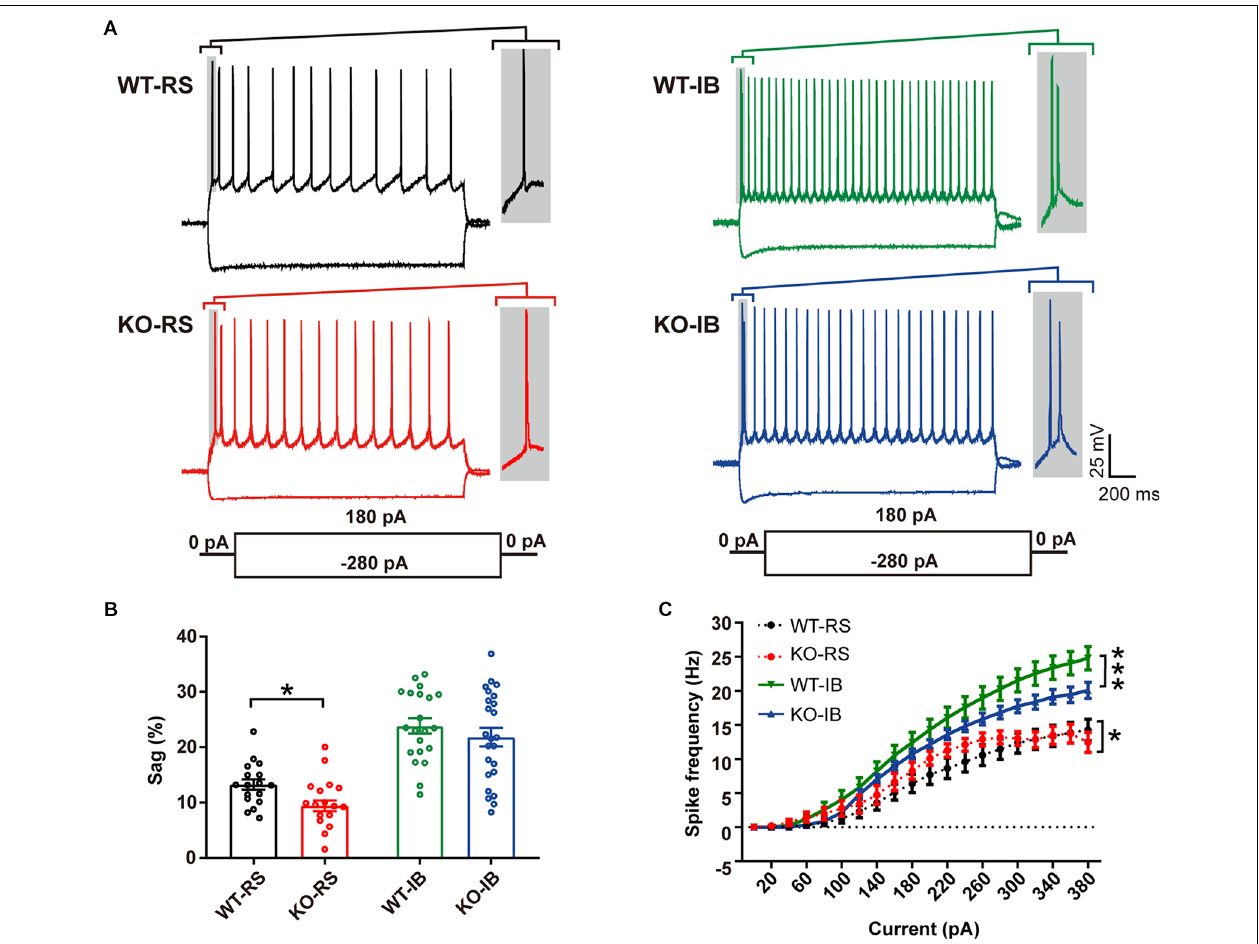
FIGURE 2 | Different intrinsic electrophysiological properties of L5 pyramidal neurons of WT and KO mice. (A) Examples of depolarizing and hyperpolarizing traces in response to current-clamp protocols shown below traces in each cell group. In each recording the initial action potentials are given in an enlarged view on the right. (B) Differences in sag ratio (WT-RS vs. KO-RS, t (32) = 2.213, p = 0.0342; WT-IB vs. KO-IB, t (43) = 0.9296, p = 0.3577; unpaired t -test). (C) I-f relationships (WT-RS vs. KO-RS, p = 0.0202; WT-IB vs. KO-IB, p < 0.0001; repeated-measures two-way ANOVA, F (57,1120) < 0.0001). * p < 0.05; *** p < 0.001.